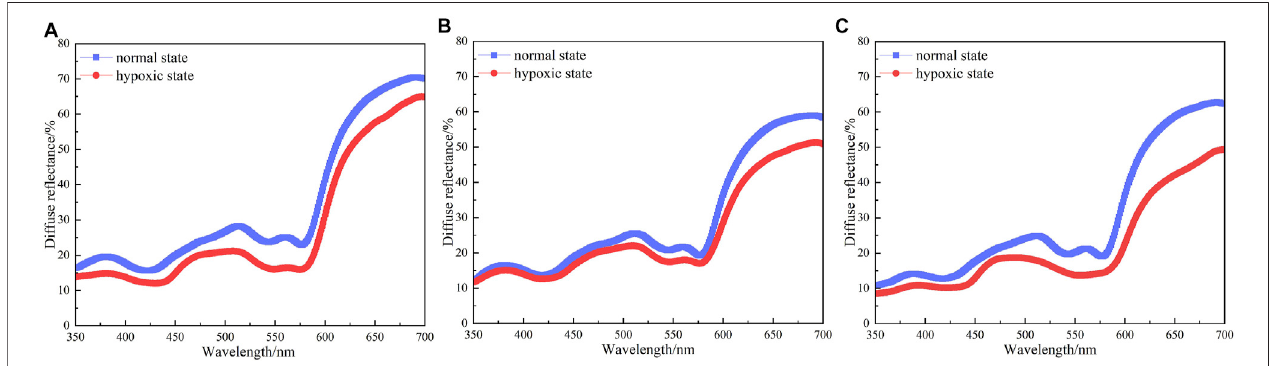
FIGURE5 | The diffusere fl ectances ofthree subjects under normal state and hypoxic state. (A) The diffuse re fl ectance ofthe subject A; (B) Thediffuse re fl ectance of the subject B; (C) The diffuse re fl ectance of the subject C.